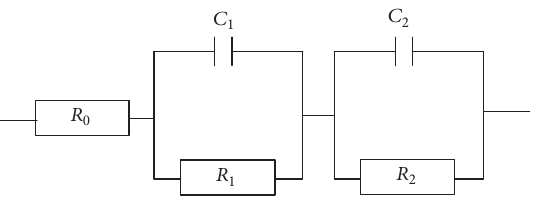
Figure 5: Equivalent circuit of the field